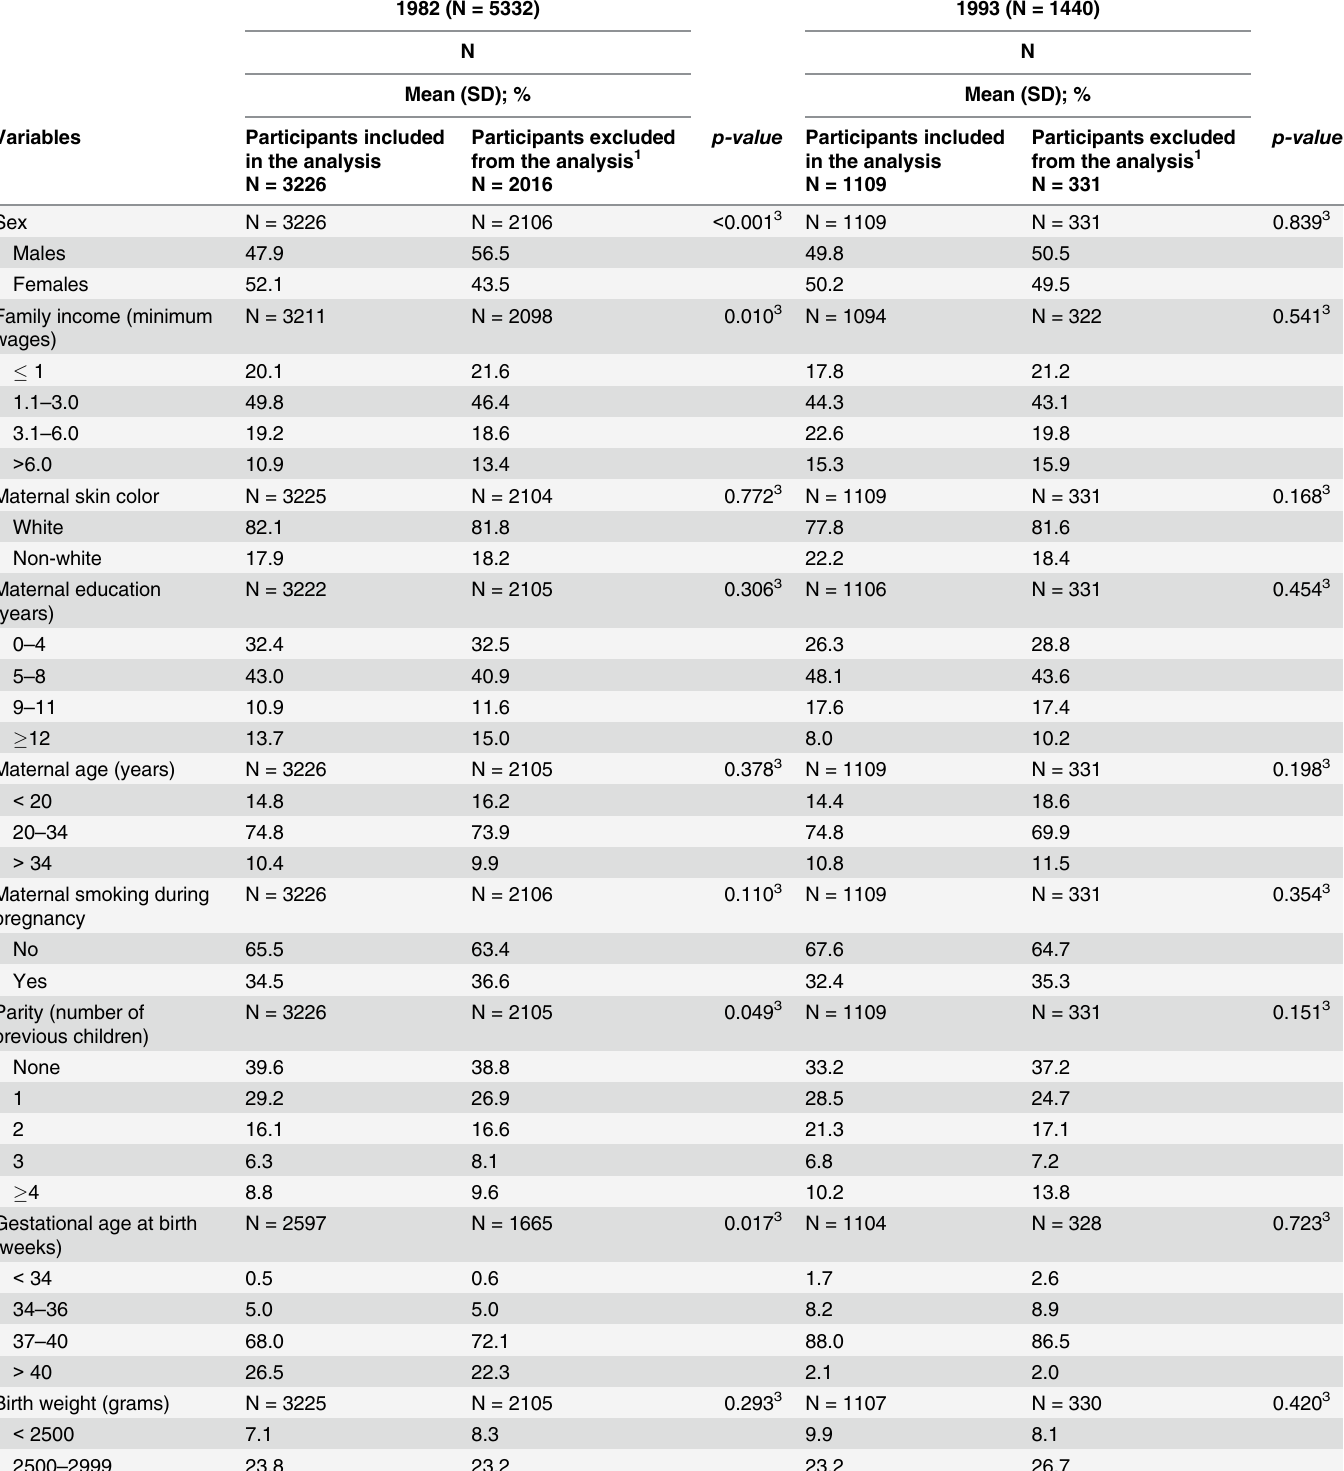
Table 1. Characteristics of the participants with complete data compared with participants not included in the analysis. The 1982 and 1993 Pelotas Birth Cohorts.